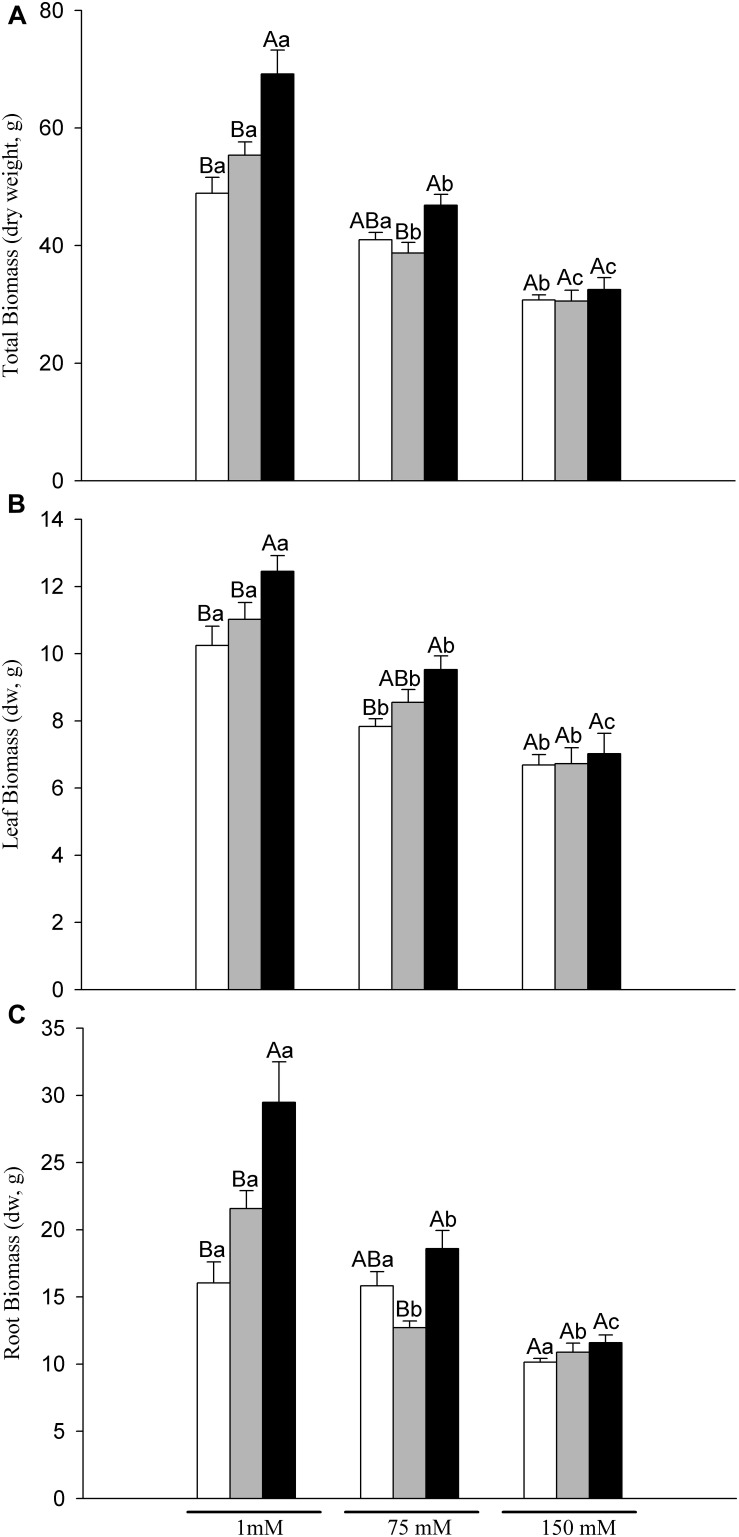
Total biomass (A), leaf (B) and root (C) dry weight of control (C, white bar), phosphorus (P, gray bar) and arbuscular mycorrhiza plants (AM, black bar) grown at 1, 75 and 150 mM NaCl. Values are mean ± SE of six replicates. Different capital letters indicate significant differences among nutritional levels (C, P and AM) within the same salt level, and lowercase letters indicate significant differences among salt levels within the same nutritional level, from post hoc Tukey test.